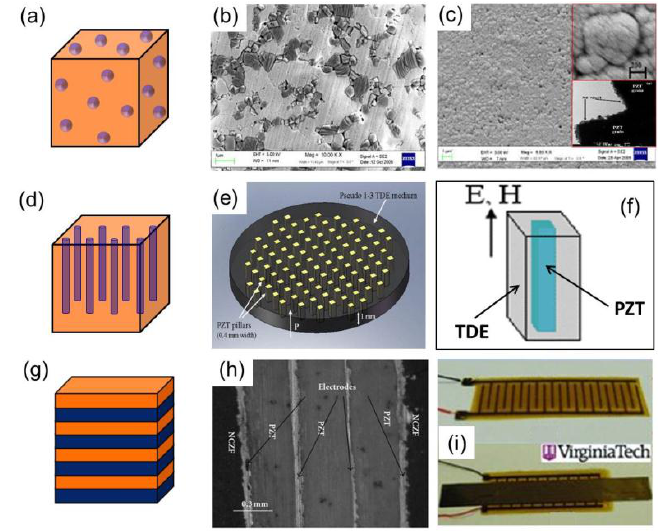
Figure 3. Development of bulk ME composites with different phase connectivity: ( a )–( c ) 0-3 connectivity [13,18]; ( d )–( f ) 1-3 connectivity [20,21]; and ( g )–( i ) 2-2 connectivity [22,24].